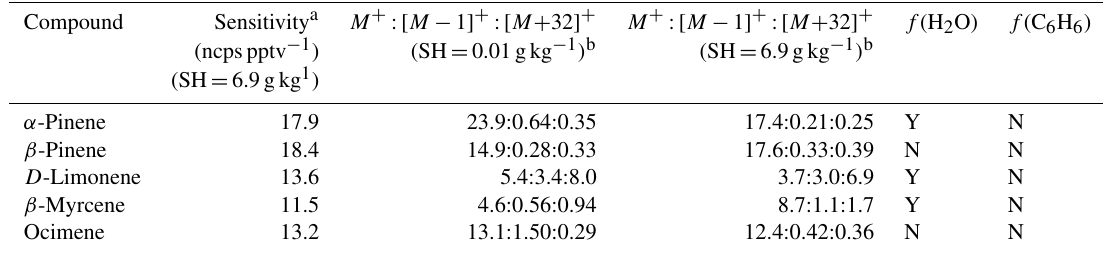
Table 1. Monoterpene sensitivities and dependence on operating and sampling conditions. Compound